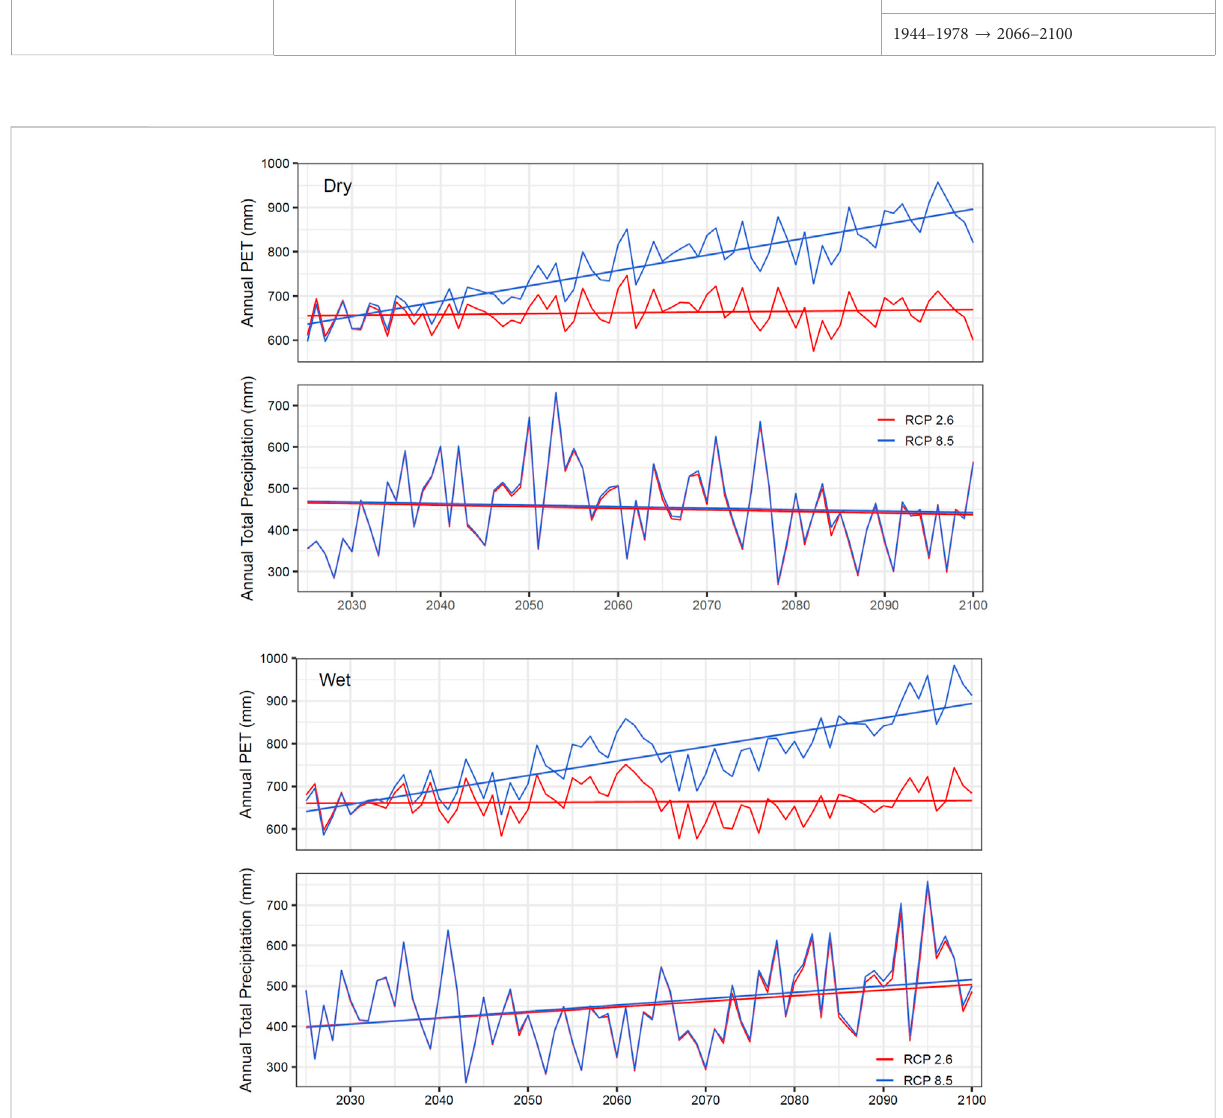
FIGURE 5 Projected precipitation and PET for RCP2.6 and RCP8.5 dry (top) and wet (bottom) climate